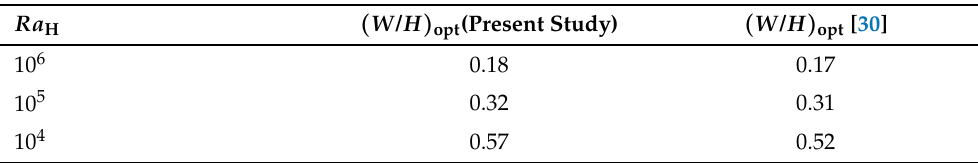
Table 4. Comparison between the numerical data obtained for ( W / H ) opt and the values derived by Olsson [30] for Ra H = 10 4 − 10 6